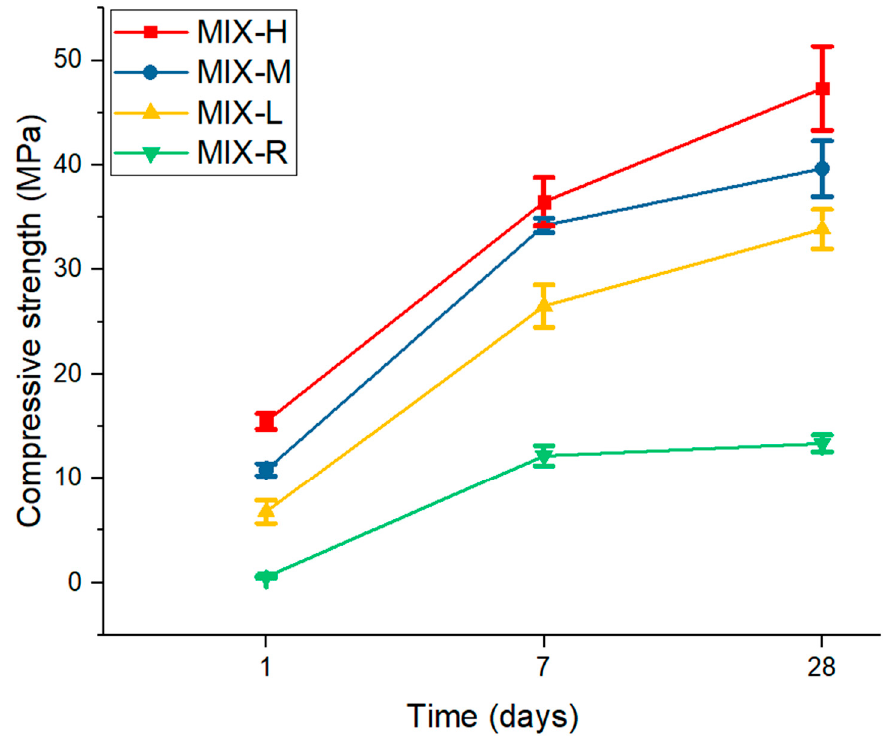
Figure 12. Measuring results of ultrasonic pulse velocity for mixtures MIX-L, MIX-M, and MIX-H. The linear fit based on measuring results from 100 min to 240 min.